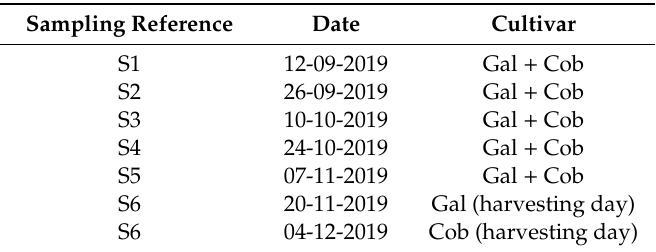
Table 1. Temporal distribution of sampling dates for each cultivar, ‘Galega Vulgar’ (Gal) and ‘Cobrançosa’